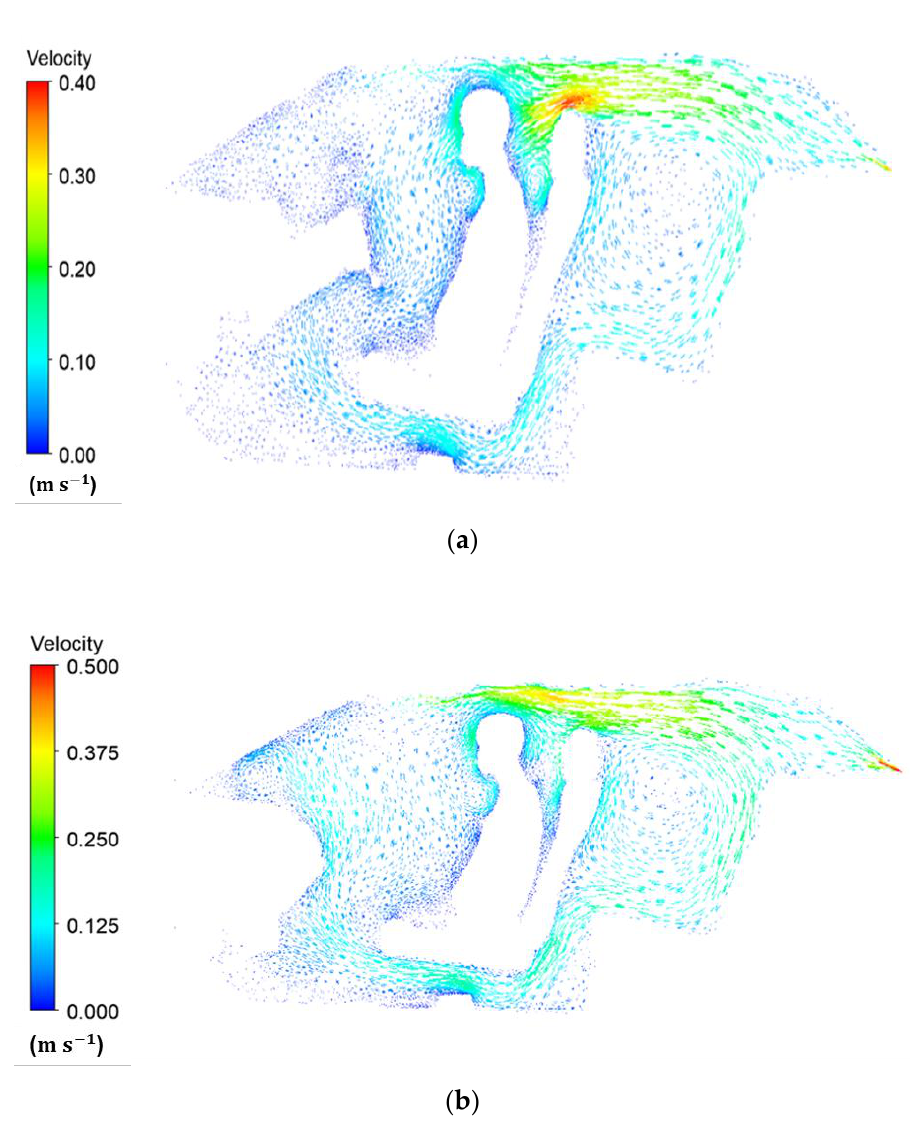
Figure 6. Velocity streamlines inside the vehicle cabin.